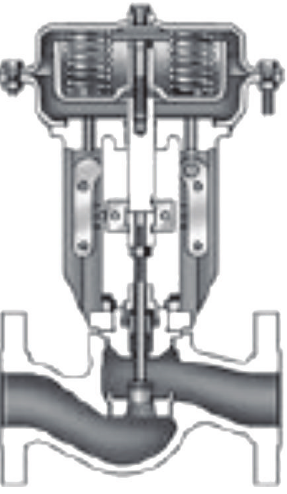
Figure 1: Pneumatic control valve with diaphragm.